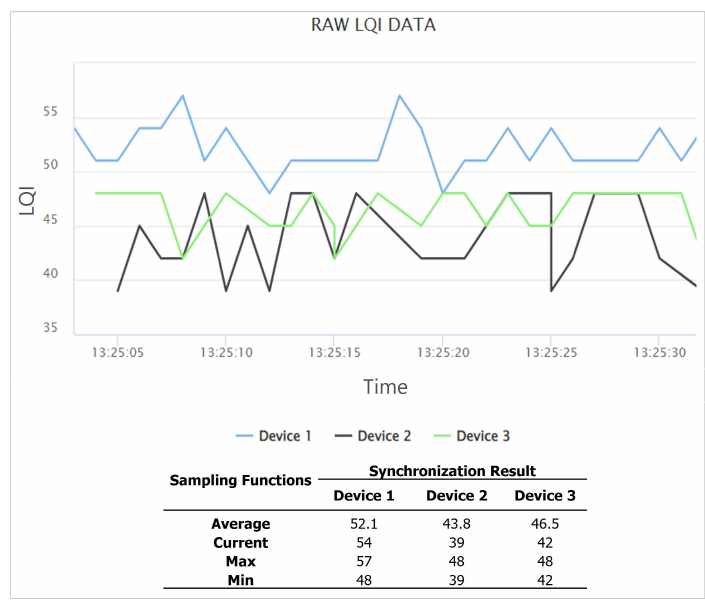
Figure 2. Interface of data synchronization